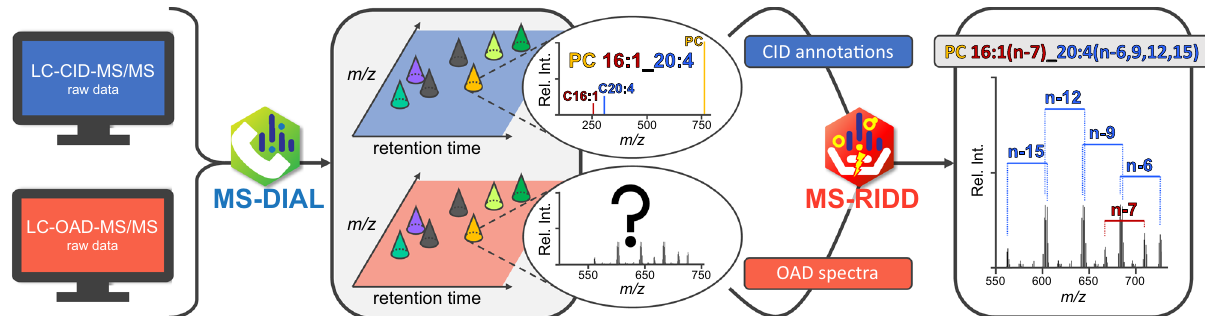
Fig. 2 MS-RIDD analysis work fl ow. Liquid chromatography – massspectrometry data (LC – MS) are initially processedby MS-DIAL,irrespective of whetherthey comprise collision-induced dissociation tandem mass spectra (LC-CID-MS/MS) or oxygen attachment dissociation tandem mass spectra (LC-OAD-MS/MS). This step includes peak picking, assignment of MS/MS spectra, and peak alignment. Additionally, based on LC-CID-MS/MS data, MS-DIAL annotates the spectra up to the lipid molecular species level, e.g. PC 16:1_20:4. The results of MS-DIAL are directly utilized by MS-RIDD, which subsequently identi fi